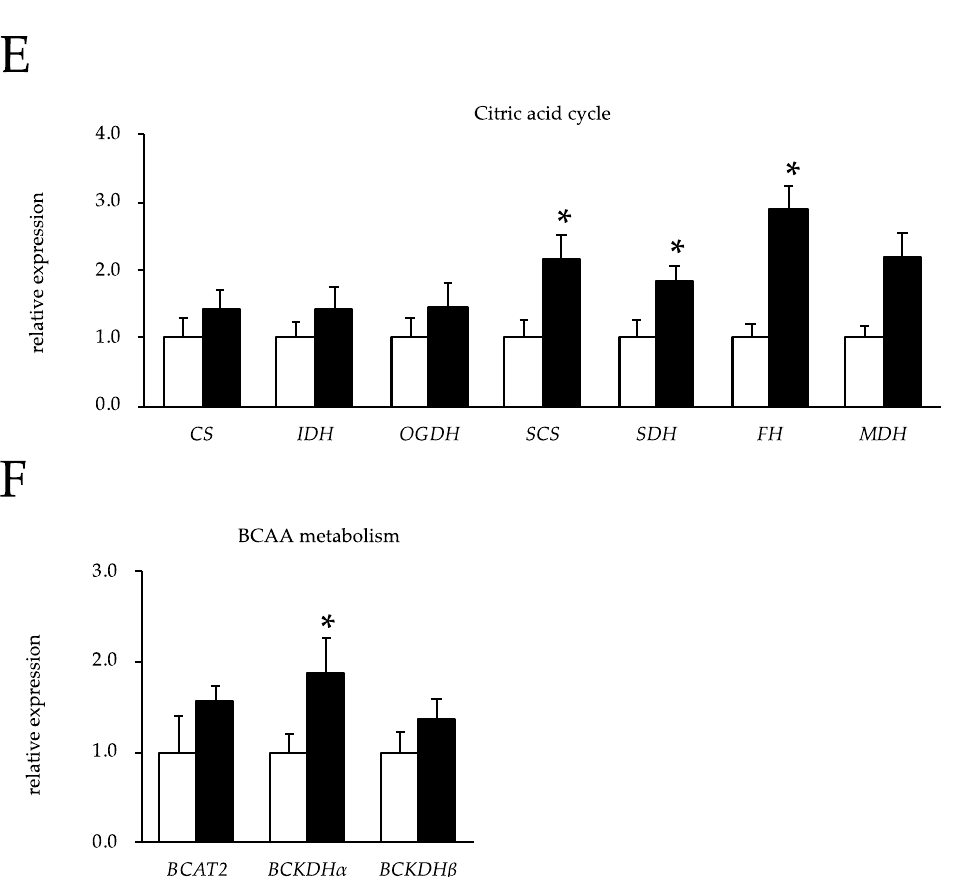
Figure 2. Gene expression analysis of livers from rats fed the OBFR diet. The expression levels of genes encoding enzymes involved in ( A ) lipid metabolism, ( B ) pyruvate metabolism and the pentose phosphate pathway, ( C ) glycolysis and gluconeogenesis, ( D ) propionate metabolism, ( E ) the citric acid cycle, and ( F ) BCAA metabolism. The open bars show the averages of the rats fed the control diet, while the closed bars show the averages of the rats fed the OBFR diet. Values are expressed as means ± the standard error ( n = 7). * OBFR differs significantly from the control ( p < 0.05). OBFR, outer bran fraction of rice; SREBP, sterol regulatory element-binding protein; FAS, fatty acid synthase; ACC,